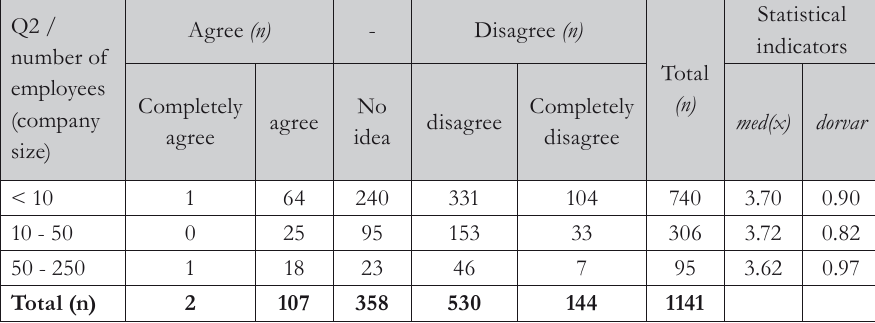
Tab. 7 – Pivot table for Q2b absolute frequency and Statistical characteristics. Source: authors Q2 /